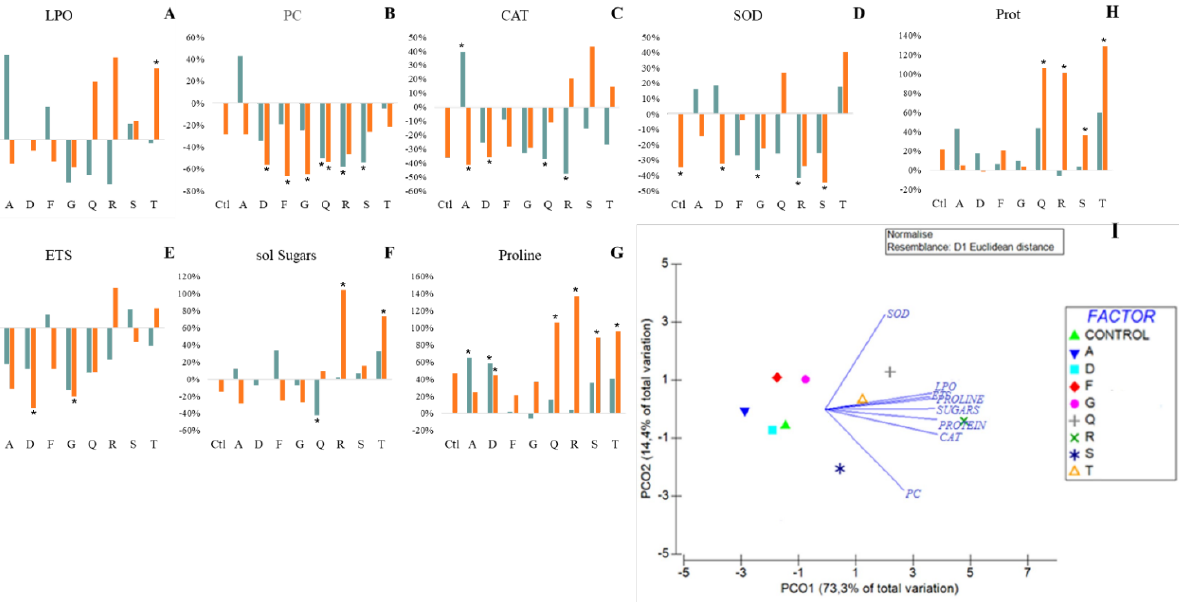
Figure 3. Biochemical parameters evaluated in maize plants grown for 7 days in watered and drought conditions: ( A ) Lipid peroxidation, ( B ) Protein carbonylation, ( C ) Catalase, ( D ) Superoxide Dismutase, ( E ) Electron Transport System, ( F ) Soluble Sugars, ( G ) Proline, ( H ) Protein, ( I ) principal coordinates ordination of biochemical parameters under drought stress. Biochemical markers variation of bacterial cells exposed to PEG50 relatively to control (not exposed to PEG). Watered (greenish bars) and drought (orange bars) plants were inoculated with different strains: Pantoea spp . (A); Pseudomonas spp . (D); Acinetobacter spp. (F); Stenotrophomonas spp . (G); Pseudomonas spp . (Q); Rhizobium spp . (R); Stenotrophomonas spp . (S); Pseudomonas spp . (T). Values are means of three replicates + standard deviation. Significant differences compared to non-inoculated watered plants (control) were marked with single asterisks ( p < 0.05) or double asterisks ( p < 0.01). For additional information (means, standard deviation and statistical significance) see supplementary Table S3.